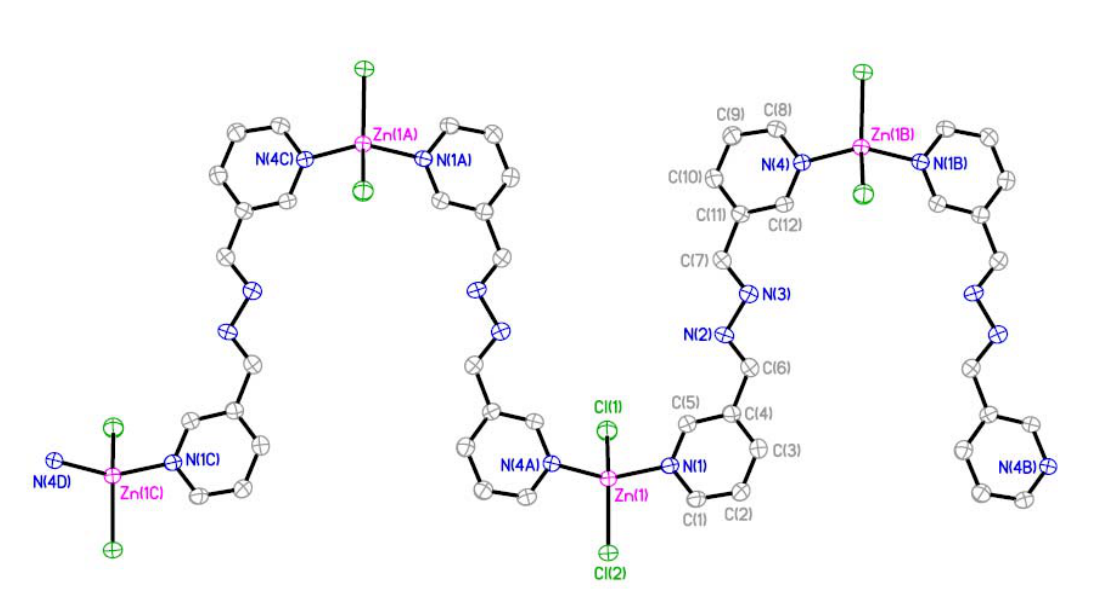
Figure 3. One-dimensional polymeric square-wave chain of compound 2 . Atomic displacement ellipsoids were drawn at 50% probability level.